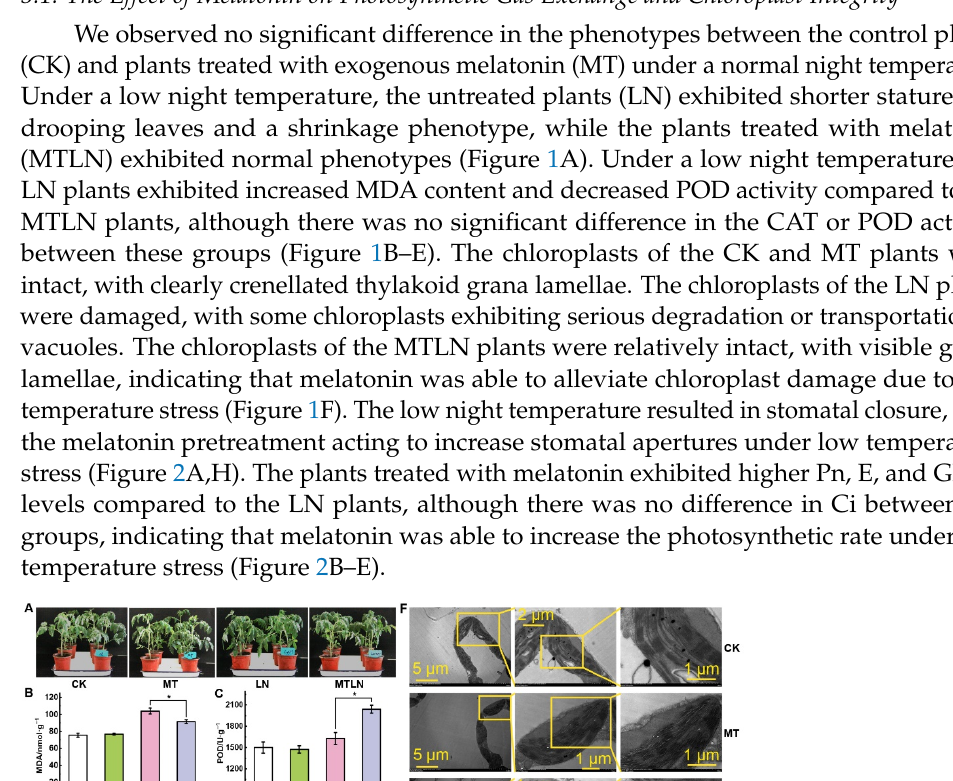
Figure 2. The effect of exogenous melatonin on photosynthetic gas exchange parameters and pho- tosystem activity of tomato plants subjected to low night temperatures. Stomatal morphology ( A ); net photosynthetic rate (Pn) ( B ); transpiration rate (E) ( C ); stomatal conductance (GH 2 O) ( D ); inter- cellular carbon dioxide concentration (Ci) ( E ); maximum photochemical reaction efficiency of PSII (Fv/Fm) ( F ); maximum oxidation state of PSI (Pm) ( G ); stomatal width ( H ); chlorophyll fluorescence imaging of Y(II) ( I ). Data are presented as the mean ± standard deviation of four to six independent biological replicates. * p -value < 0.05; student’s t -test.